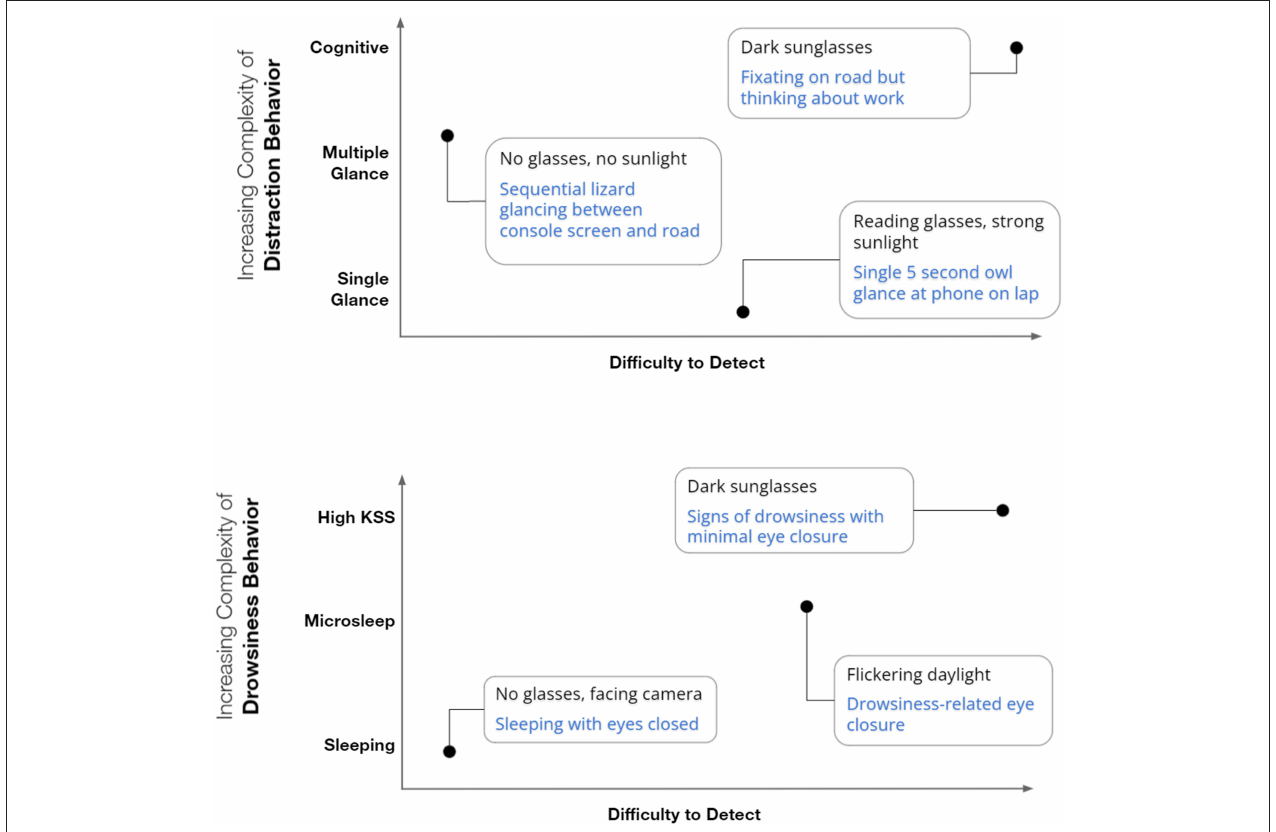
FIGURE 2 | The behavior-technology matrix for distraction (top) and drowsiness (bottom) that describes different levels of camera-based OSM technology performance. Within each figure the blue text represents the complexity of driver behavior, while the black text represents noise variables that could alter detection